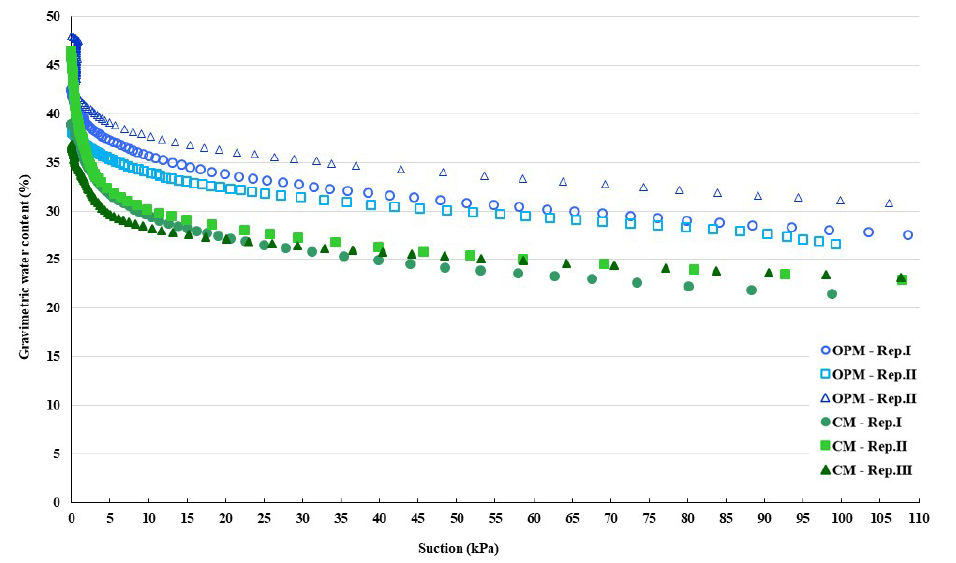
Figure 1. Soil water retention curves for each replicate ( n = 3) for the two treatments: optimized management (OPM) vs. conventional management (CM). Table 2. S -index values, contents of water ( θ ) and suction ( (cid:57) ) corresponding to the inflection point, obtained with the van Genuchten equation and van Genuchten parameters. Mean ± standard deviation of the mean ( n = 3). All the differences are not statistically significant ( p > 0 . 05).